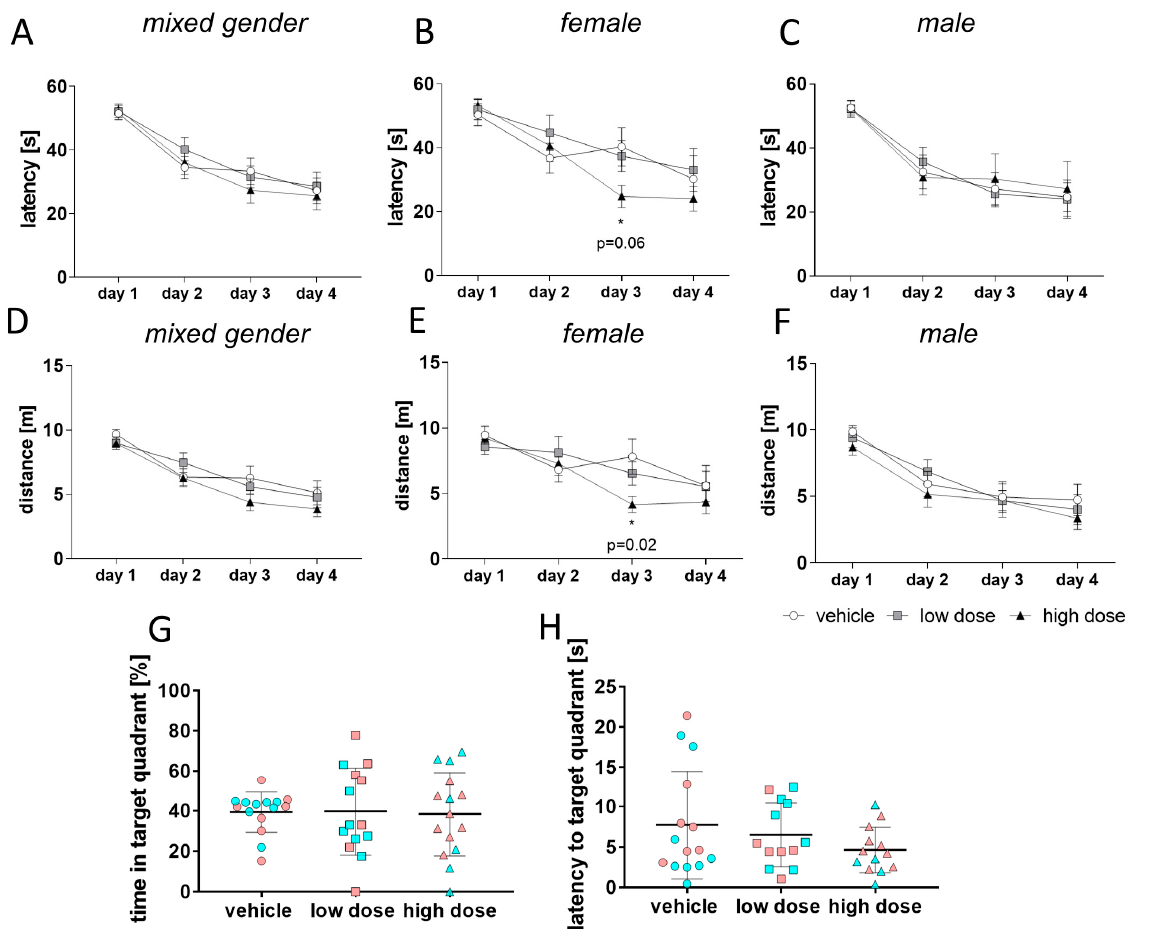
Figure 7. Learning and memory in the Morris water maze (MWM). Mice were tested in the MWM ( n = 14–15/group). ( A – C ) Latency to target contact in the learning phase did not reveal a significant difference between groups ( A ) when tested regardless of gender. When female mice were analyzed separately ( n = 7–8/group), a trend ( p = 0.06) to better learning was detected on day 3 between vehicle and high-dose treatment groups ( B ). Separate analysis of male mice revealed no significant difference between groups amongst males ( C ). ( D – F ) Analysis of distance revealed no significant difference between groups ( D ) when tested regardless of gender. When female mice were analyzed separately, they showed shorter distances, which were significant on day 3 ( E ). Separate analysis of male mice revealed no significant difference between groups amongst males ( F ). Memory tests on day 5 revealed no significant difference between groups regardless of gender (pink = female, blue = male) ( G , H ). Data are shown as mean +/ − SEM. Two-way ANOVA ( A – F ) or one-way ANOVA ( G , H ) was performed with Tukey’s post hoc test. p -values of p < 0.05 were considered significant (*) and p < 0.07 were considered as trend.